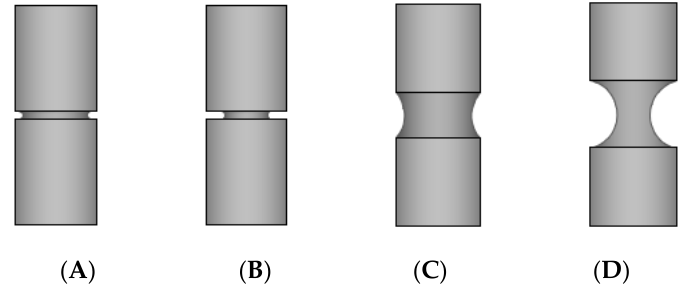
Figure 3. Scheme of axisymmetric notched specimens A, B, C, and D.